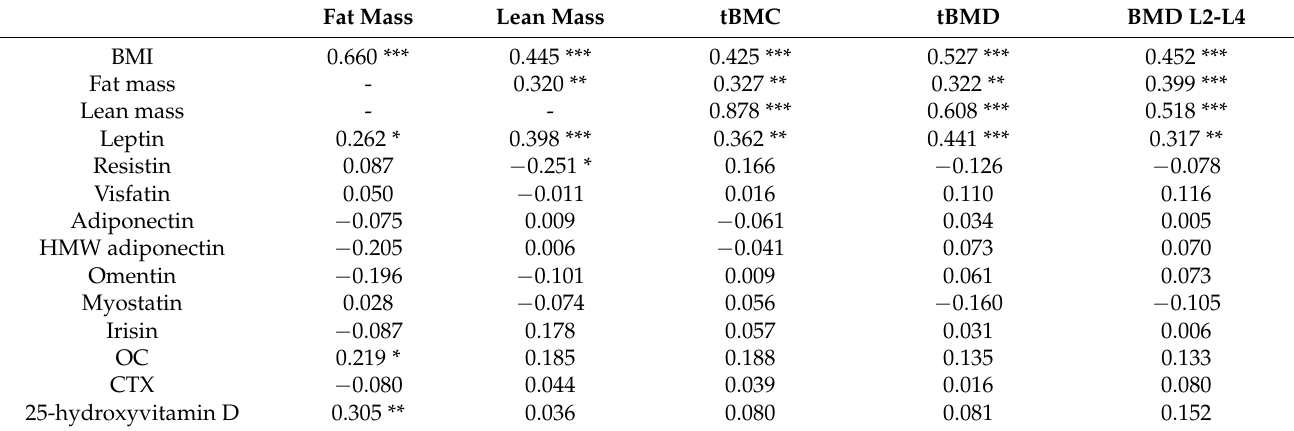
Table 4. Correlations between body composition and bone mineral density with serum adipokines, myokines and bone metabolism markers in the whole group of children ( n =